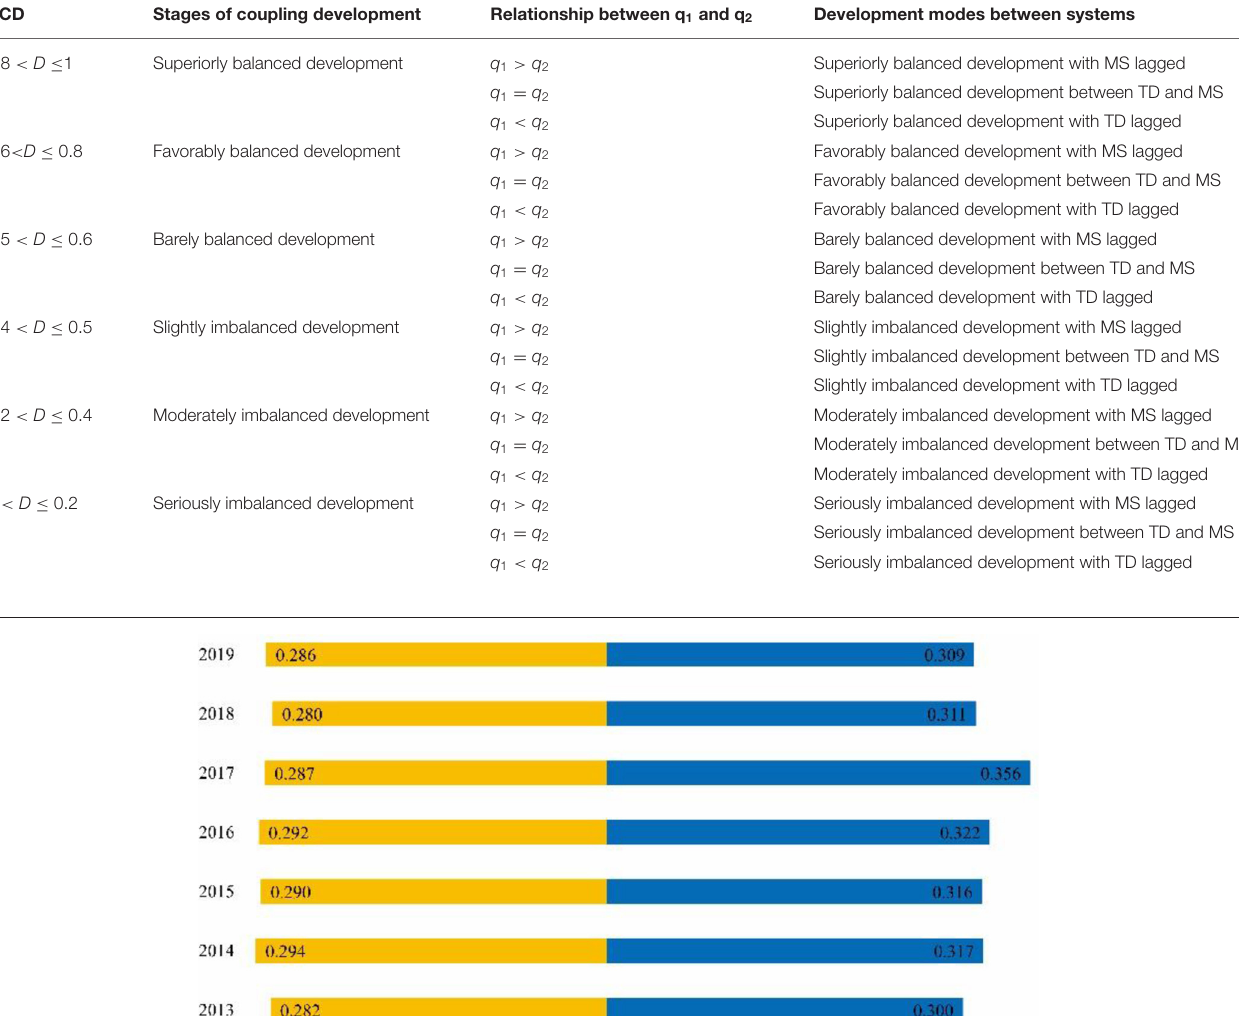
TABLE 2 | Classification standard of coupling coordination types between tourism development (TD) and medical services